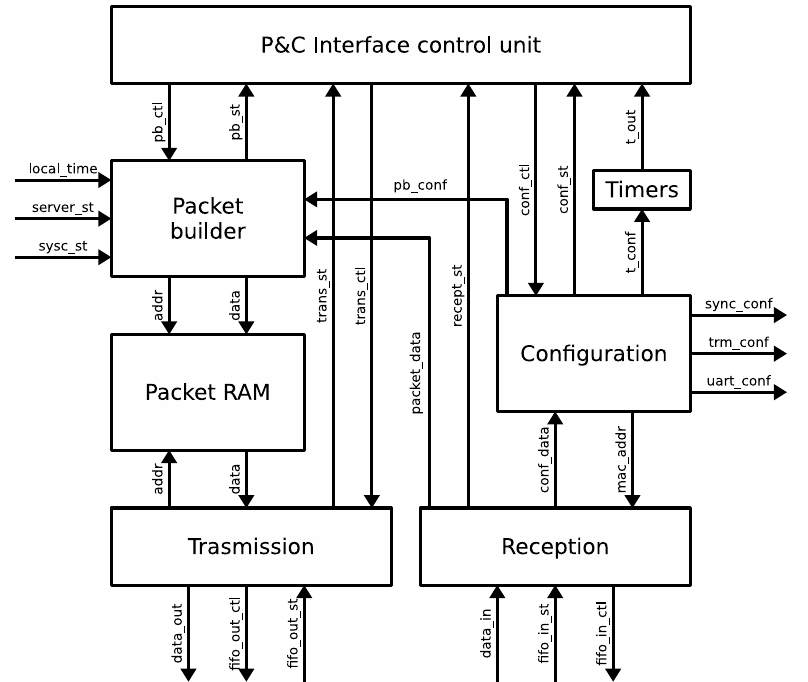
Figure 13. Protocol and configuration interface block